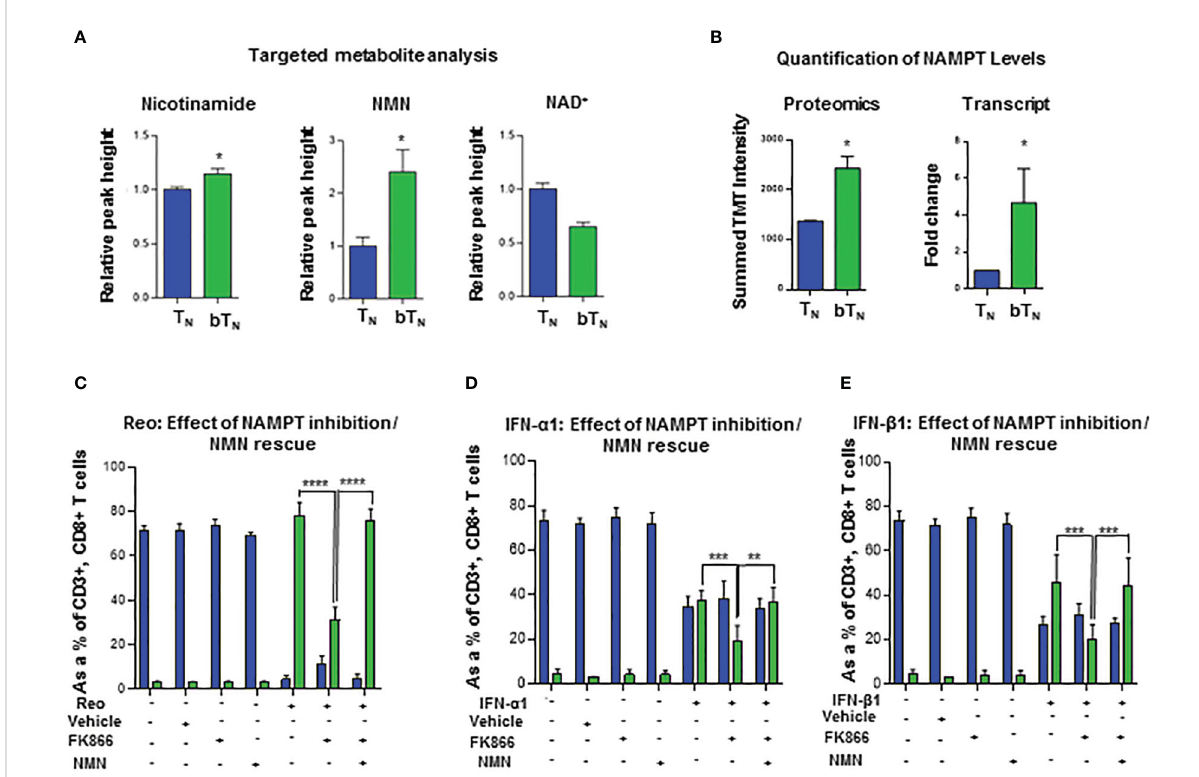
FIGURE 6 NAD + salvage metabolism regulates induction of CD8 bT N cells. (A) Bar graphs depicting the relative peak heights of NAD + salvage metabolites - NAM, NMN and NAD + - using targeted metabolomics (n=4 mice per group). (B) Bar graphs for NAMPT levels- proteomics (n=5 mice pooled per condition) and quantitative PCR analysis (n = 3 independent experiments). (C – E) Bar graphs show the induction of CD8 bT N cells upon ex vivo treatment of splenocytes from C57BL/6 mice with reovirus (MoI = 10) (C) IFN- a 1 (20 U/mL) (D) , and IFN- b 1 (20 U/mL) (E) in the presence of FK866 (5nM) and NMN (200µM) (n=3 independent experiments for each treatment, ethanol vehicle control for FK866). Two-tailed student t- test used for statistical analysis for (A, B) Two-way ANOVA with Tukey ’ s multiple comaprisons and 95% con fi dence interval was used for statistical analysis of (C – E) Not signi fi cant (ns) = p > 0.05; *p < 0.05; **p < 0.01; ***p < 0.001; **** p